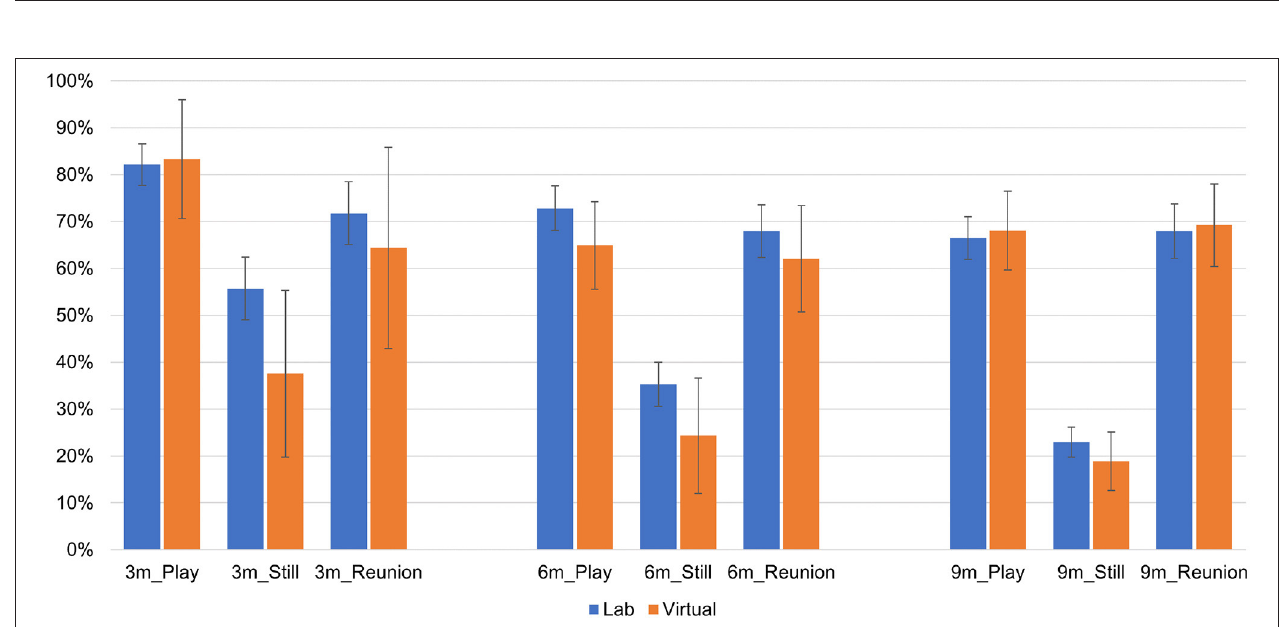
FIGURE 6 | Infant gaze to mother at each time point as a function of Still Face episode and visit type.